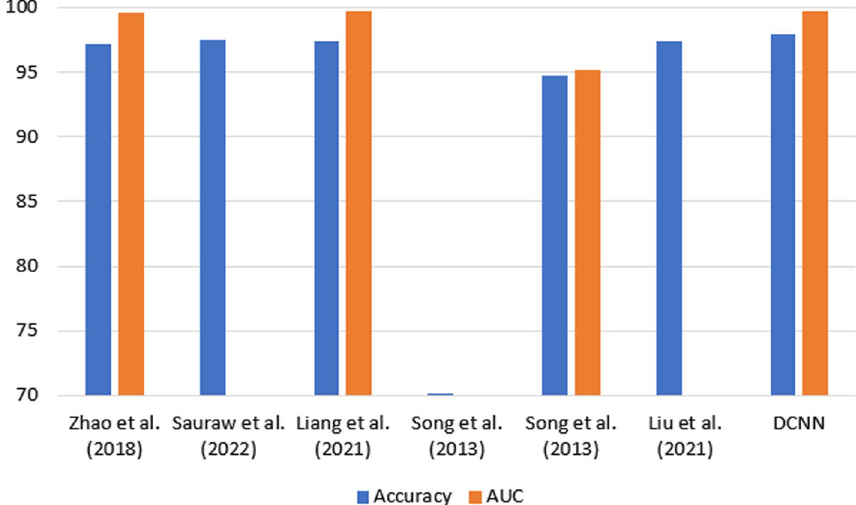
Fig. 10 Comparison of per- formance metrics according to accuracy and AUC values by previous studies on the CEW